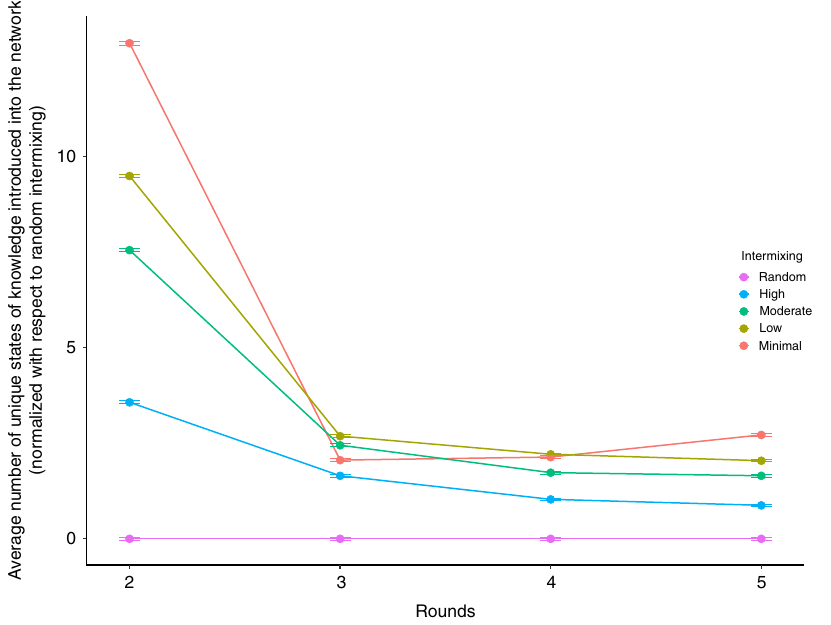
Fig. 7 Unique knowledge produced by diverse knowledge intermixing. The average marginal number of unique states of knowledge over time for the diversity of knowledge simulations — as compared to the number of unique solutions generated by random intermixing networks — by intermixing rate. Error bars are the standard errors measured across NK spaces